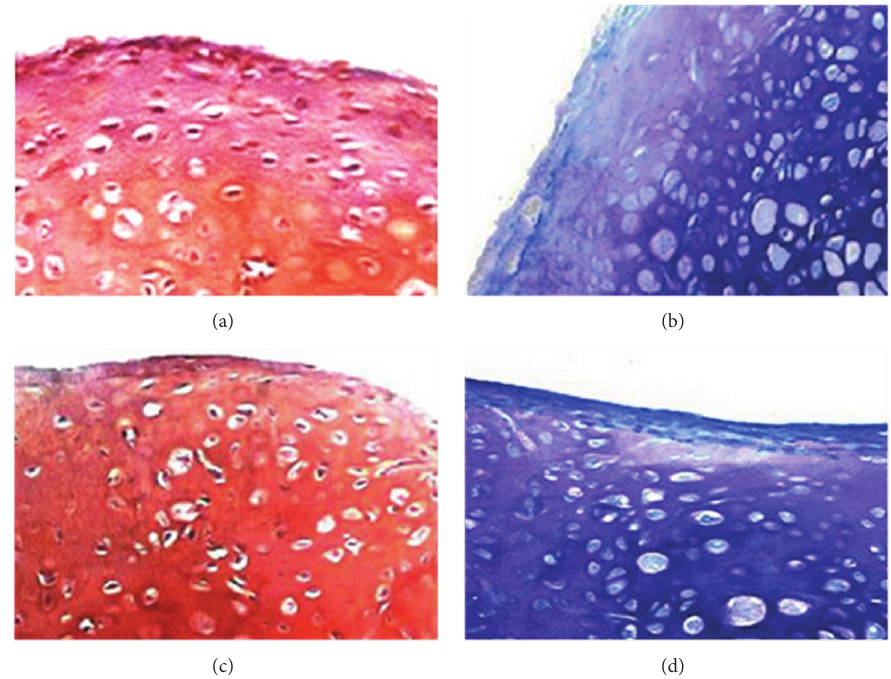
Figure 4: Chondrogenesis of bone marrow-derived stem cells (BMSCs) in PRP and CCIAs groups. Chondrogenic differentiation of BMSCs pellets was confirmed after being cultured in complete medium with PRP or CCIAs for 3 weeks. There was expression of chondrocytes related extracellular matrix as indicated by safranin O (a, c) and alcian blue staining (b, d) for both groups. Magnification: × 200